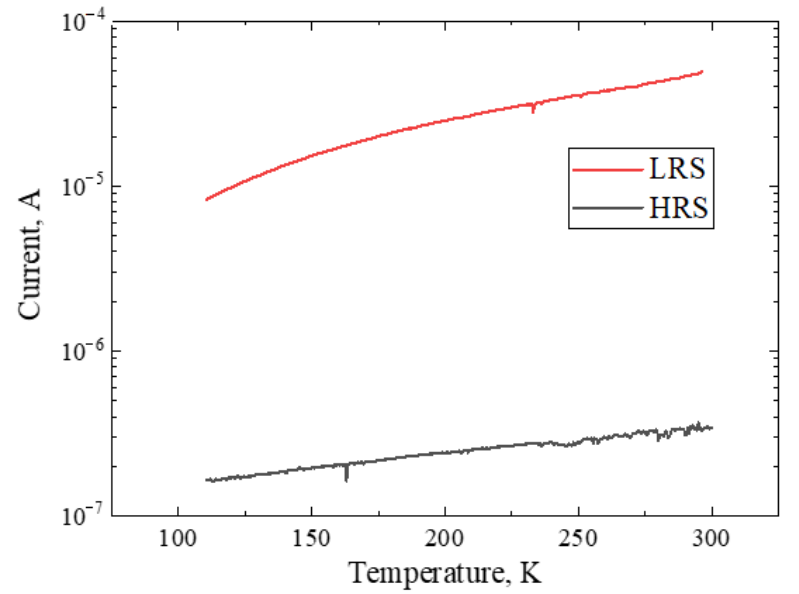
Figure 9. Current dependence on temperature in HRS ( black ) and LRS ( red ) states for C12A7:e − .